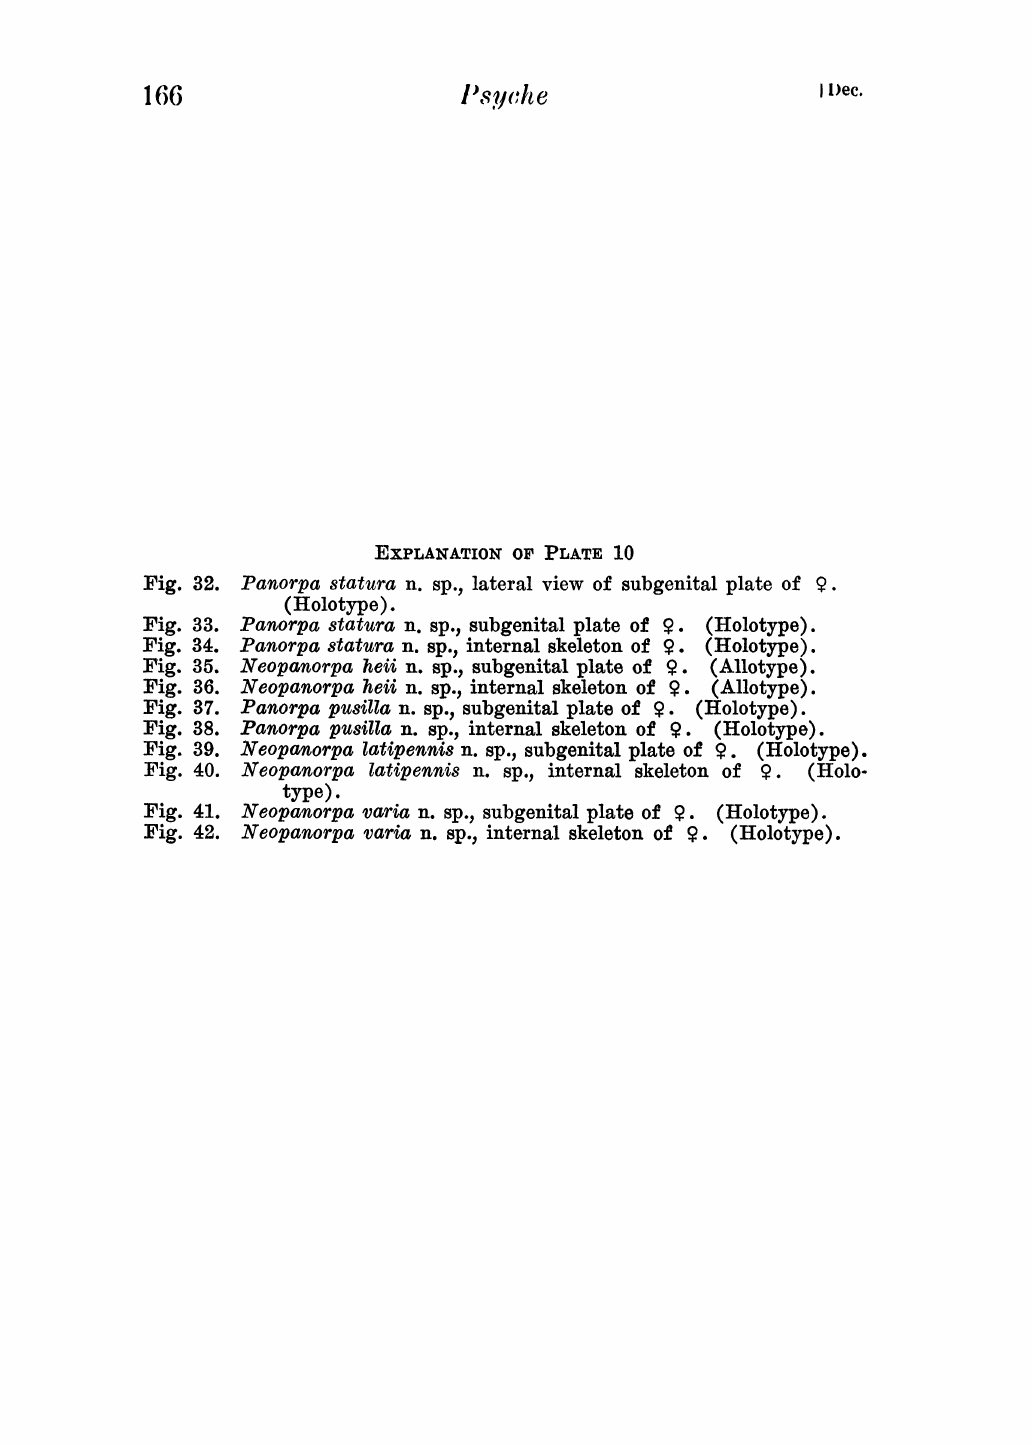
EXPIANATIO OF PLATE 10